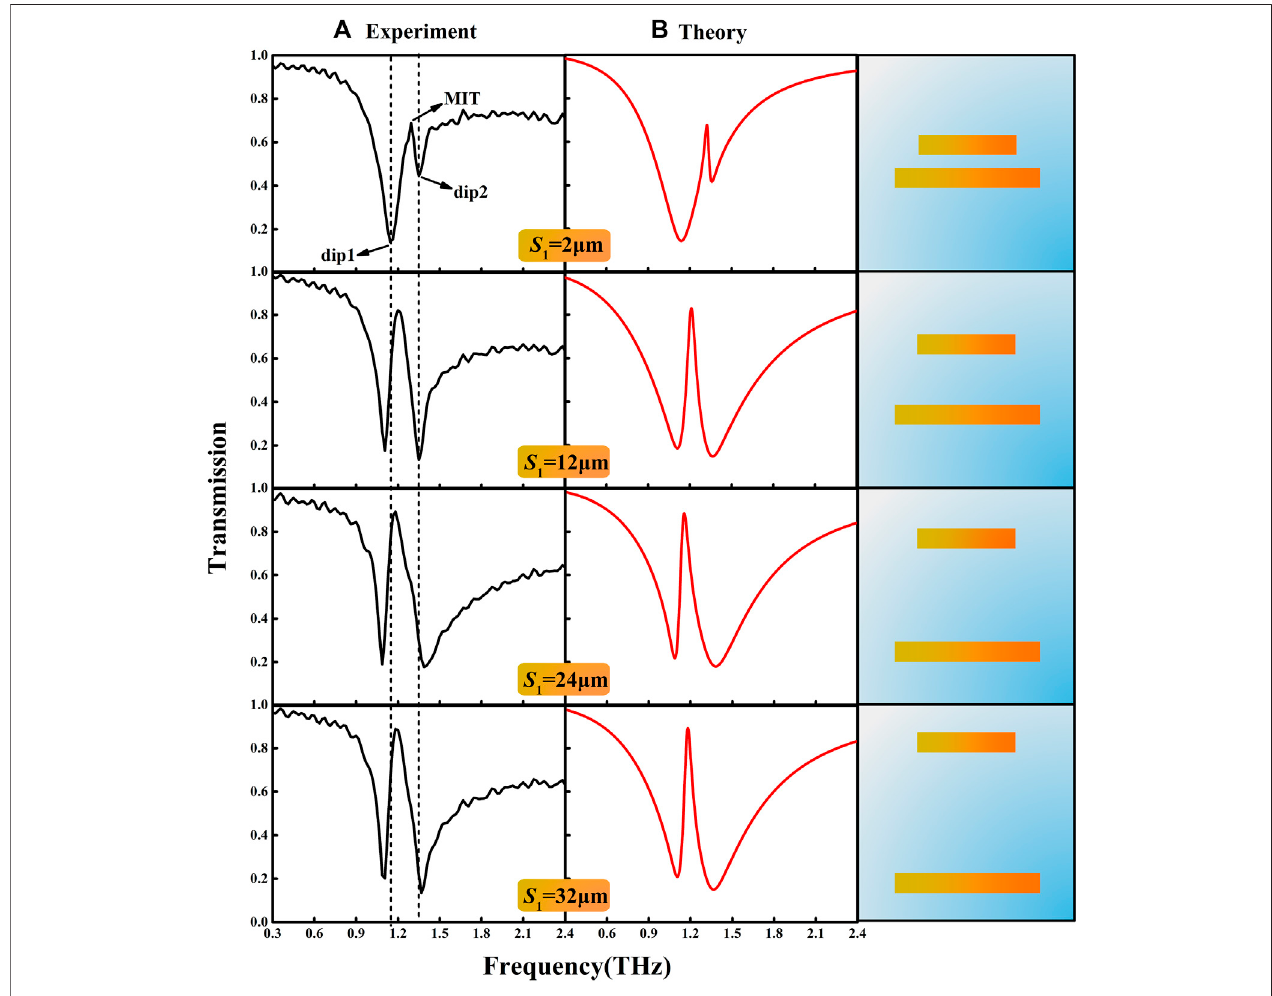
FIGURE 3 | Evolution of transmission spectra for M12 with different S 1 of 2, 5, 24, and 32 μ m, respectively. (A) Experimental transmission spectra. (B) Corresponding theoretical fi tting results with the Lorentz oscillator model.